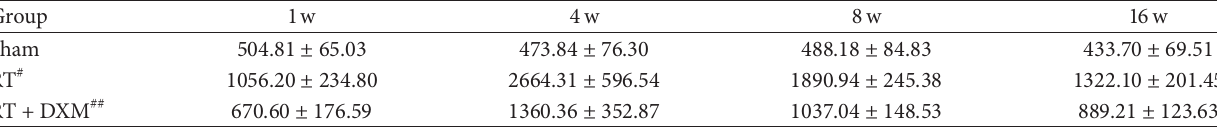
Table 1: The average optical density of IL-17A analysis and comparison in each group ( 𝑛 = 5 , mean ± SD). Group 1w